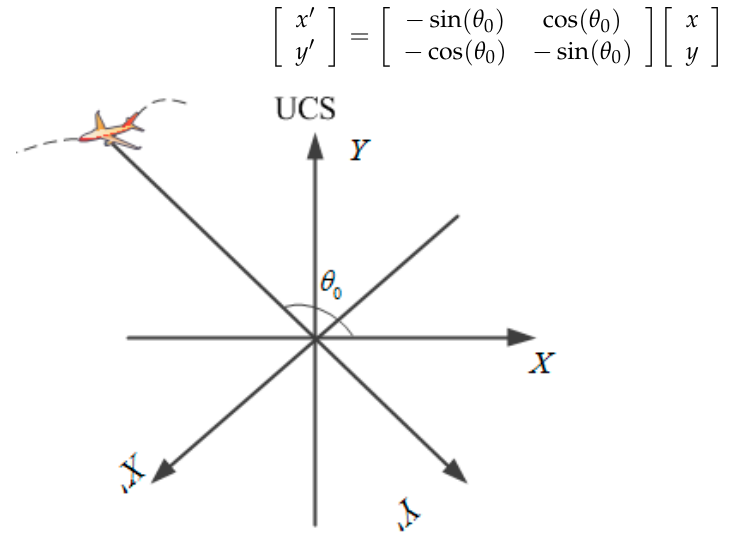
Figure 4. Rotated images into UCS.